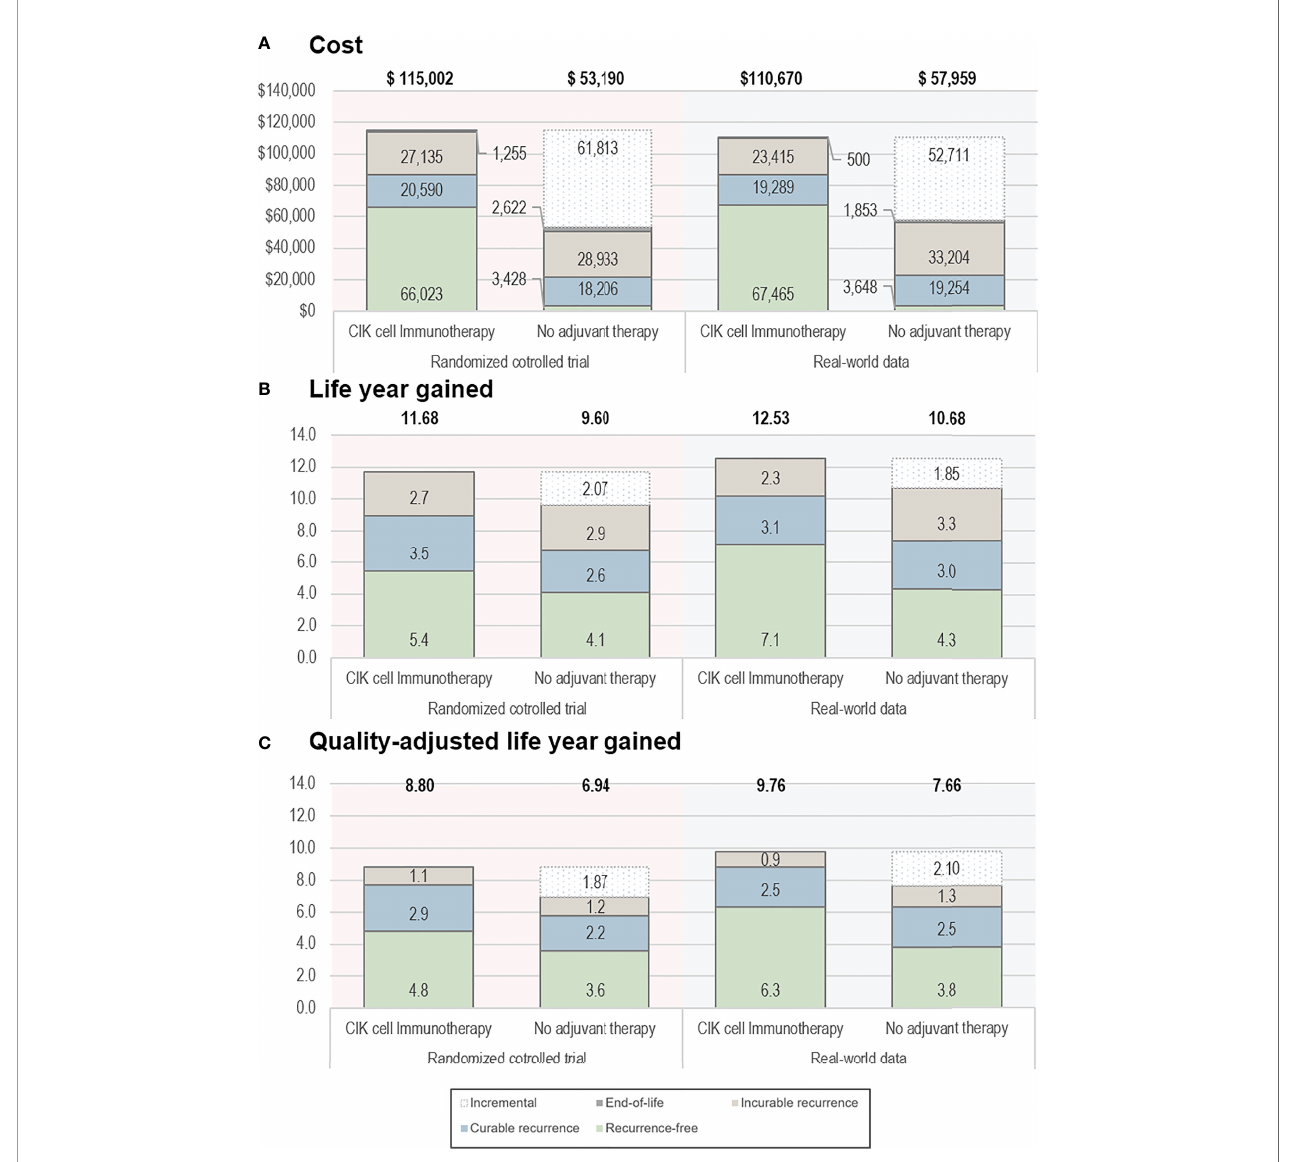
FIGURE 2 | Base-case results. (A) Cost, (B) life-year gained, and (C) quality-adjusted life-year gained. The bold text indicates the total value estimated from the analyses. CIK, cytokine-induced